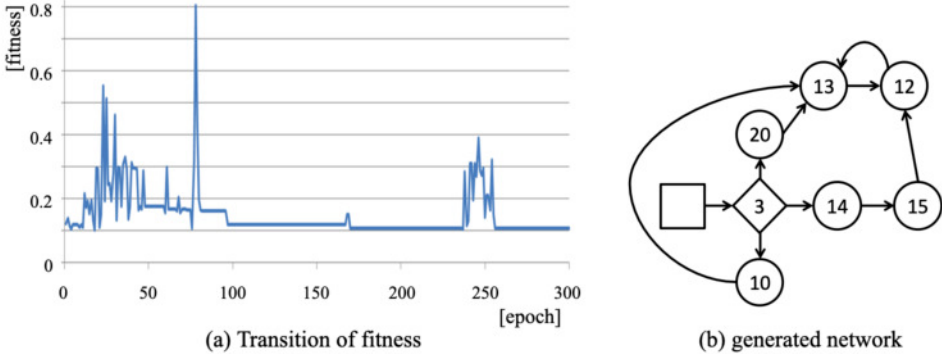
Figure 5. Experimentally obtained results of optimizing sensor signals to approximate high-accuracy ideal signals.